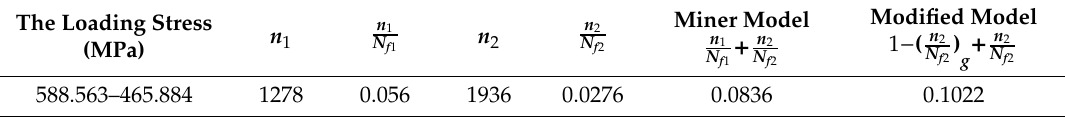
Table 4. Fatigue damage of high pressure turbine disc under external loading spectrum of 750 h. The Loading